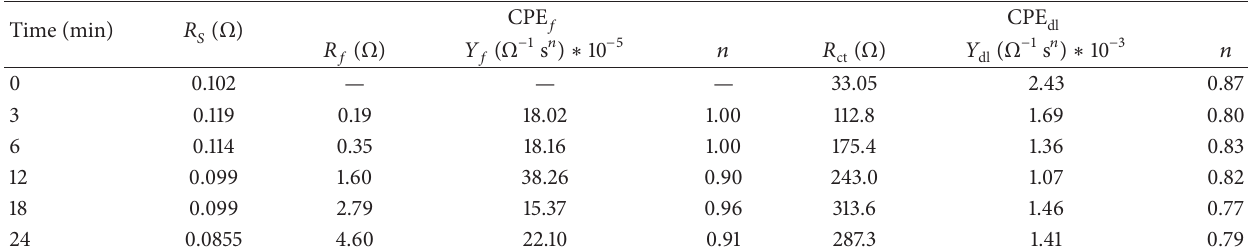
and inhibitor B to base mixture. 2